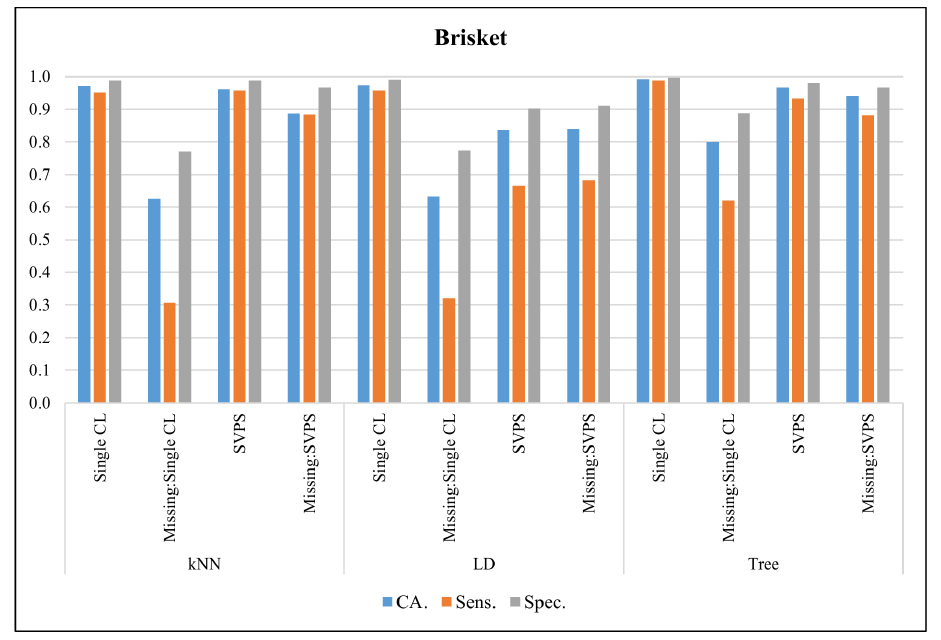
Figure 4. Classification results for Brisket